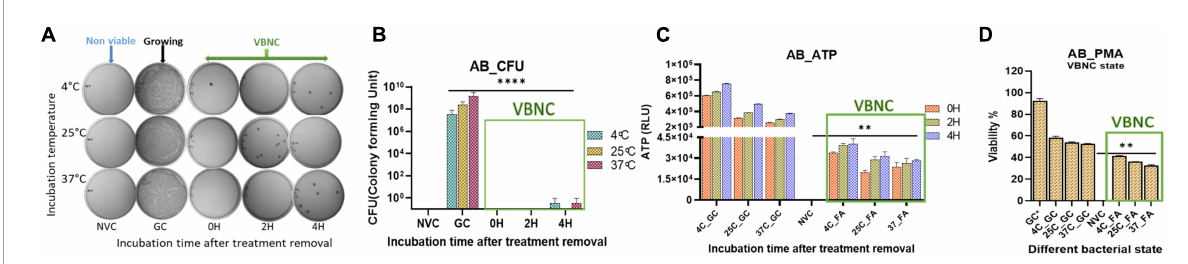
FIGURE2 Viable-but-non-culturable (VBNC) validation after VBNC induction was further confirmed on day 10. VBNC induction by culturability and ATP production up to 4 h after formic acid (FA) removal and addition of fresh media. Furthermore, viability percentage was checked on the basis of membrane integrity in all the study isolates and at all three incubation temperatures. VBNC induction confirmation in Acinetobacter baumannii ( Klebsiella pneumoniae and E. coli refer Supplementary Figure 2 ) culturability detection (A) , quantitative representation of culturability (B) , ATP production (C) , and propidium monoazide (PMA) PCR assay (D) . FA-induced VBNC at all three incubation temperatures did not resume detectable growth up to 4 h after removal of FA and incubation under optimal growth conditions. After removal of FA, higher ATP levels indicated de novo metabolic energy production in non-culturable state of A. baumannii (C) . PMA PCR results showed up to 45% population maintained intact cell membranes in the VBNC state (D) . FA treatment in combination with 4 ◦ C incubation induced more VBNC forms when compared to 25 and 37 ◦ C. While viability percentage of 37 ◦ C incubation was significant when compared to the non-viable control. FA, formic acid; GC, growing control; NVC, non-viable control; 4C, sample incubated at 4 ◦ C; 25C, sample incubated at 25 ◦ C; 37C, sample incubated at 37 ◦ C; D_2, sample tested after 2 days of FA treatment; D_4, sample tested after 4 days of FA treatment; D_10, sample tested after 10 days of FA treatment; CFU, colony formic unit; RLU, relative light unit; AB, Acinetobacter baumannii , ** P -valve < 0.05, and **** P -valve <